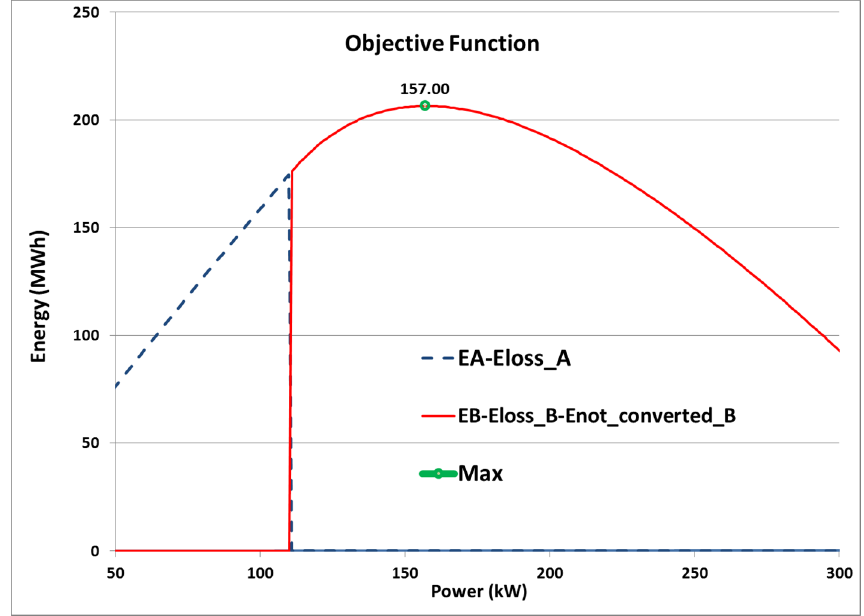
Figure 6. Objective function curve calculated for the city of Palermo,